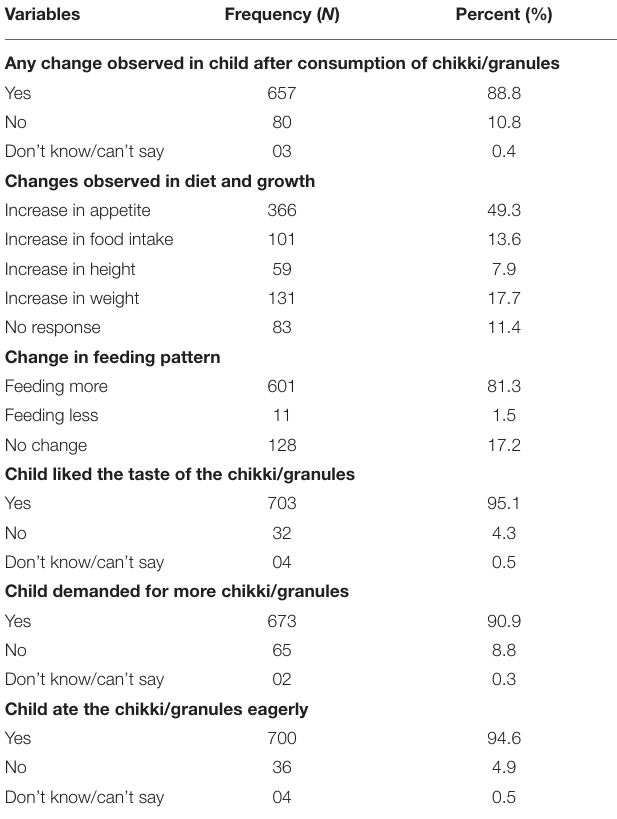
TABLE 3 | Spirulina chikkis/granules received and consumed by the beneficiaries. Indicators